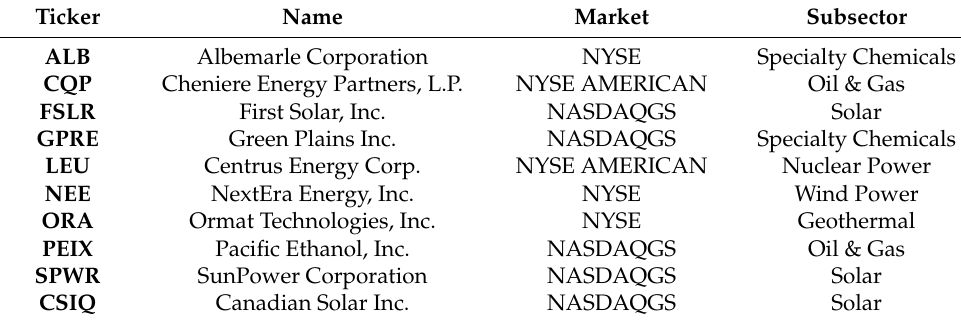
Table 1. Renewable Energy